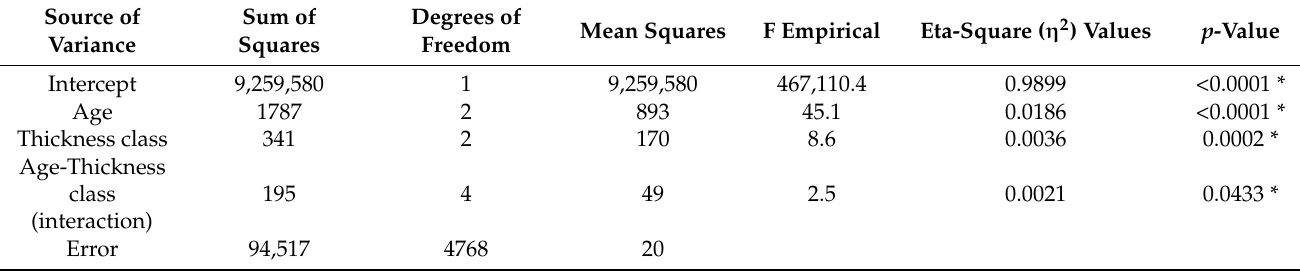
Table 9. Effect on wood hardness of tree age and thickness class and the interaction of these factors (two-way analysis of variance).